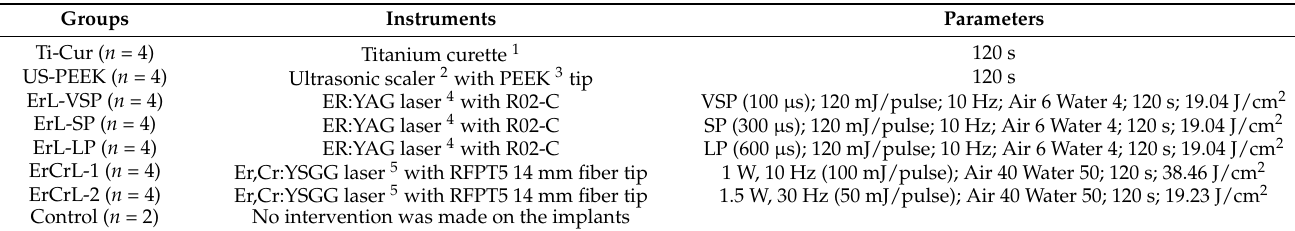
Table 1. Treatment